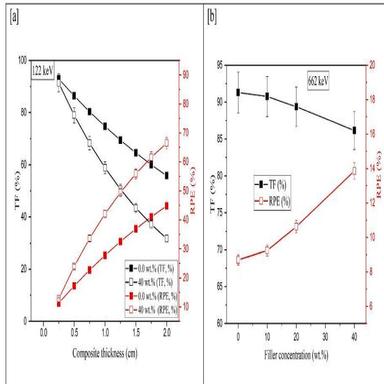
Shows the RPE and TF dependence on composite thickness, filler concentration.